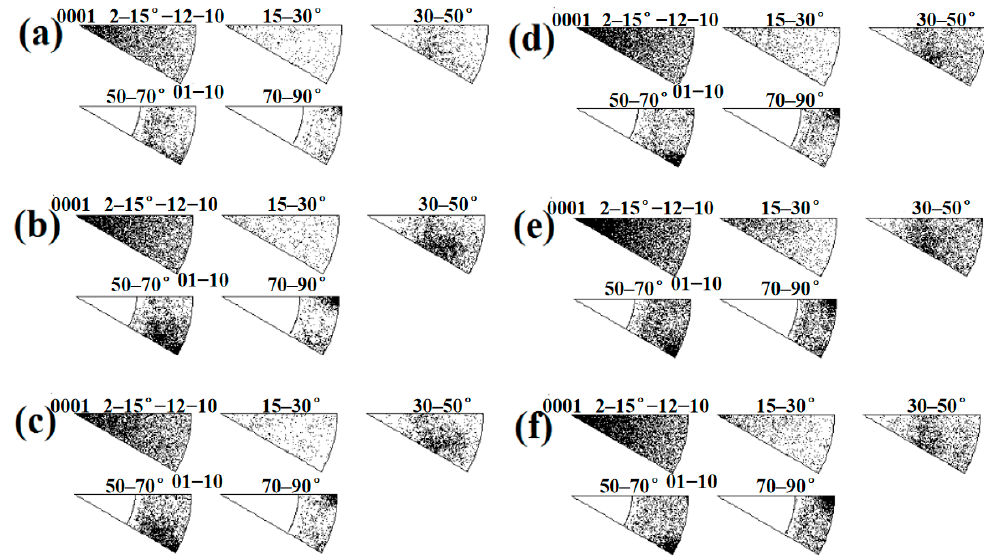
Figure 24. Misorientation-axis distributions measured at various subdomains in specimens B3 and C3. ( a ) Ti-1; ( b ) Ti-2; ( c ) Ti-3; ( d ) Ti-I; ( e ) Ti-II; ( f ) Ti-III. C3. ( a ) Ti-1; ( b ) Ti-2; ( c ) Ti-3; ( d ) Ti-I; ( e ) Ti-II; ( f )